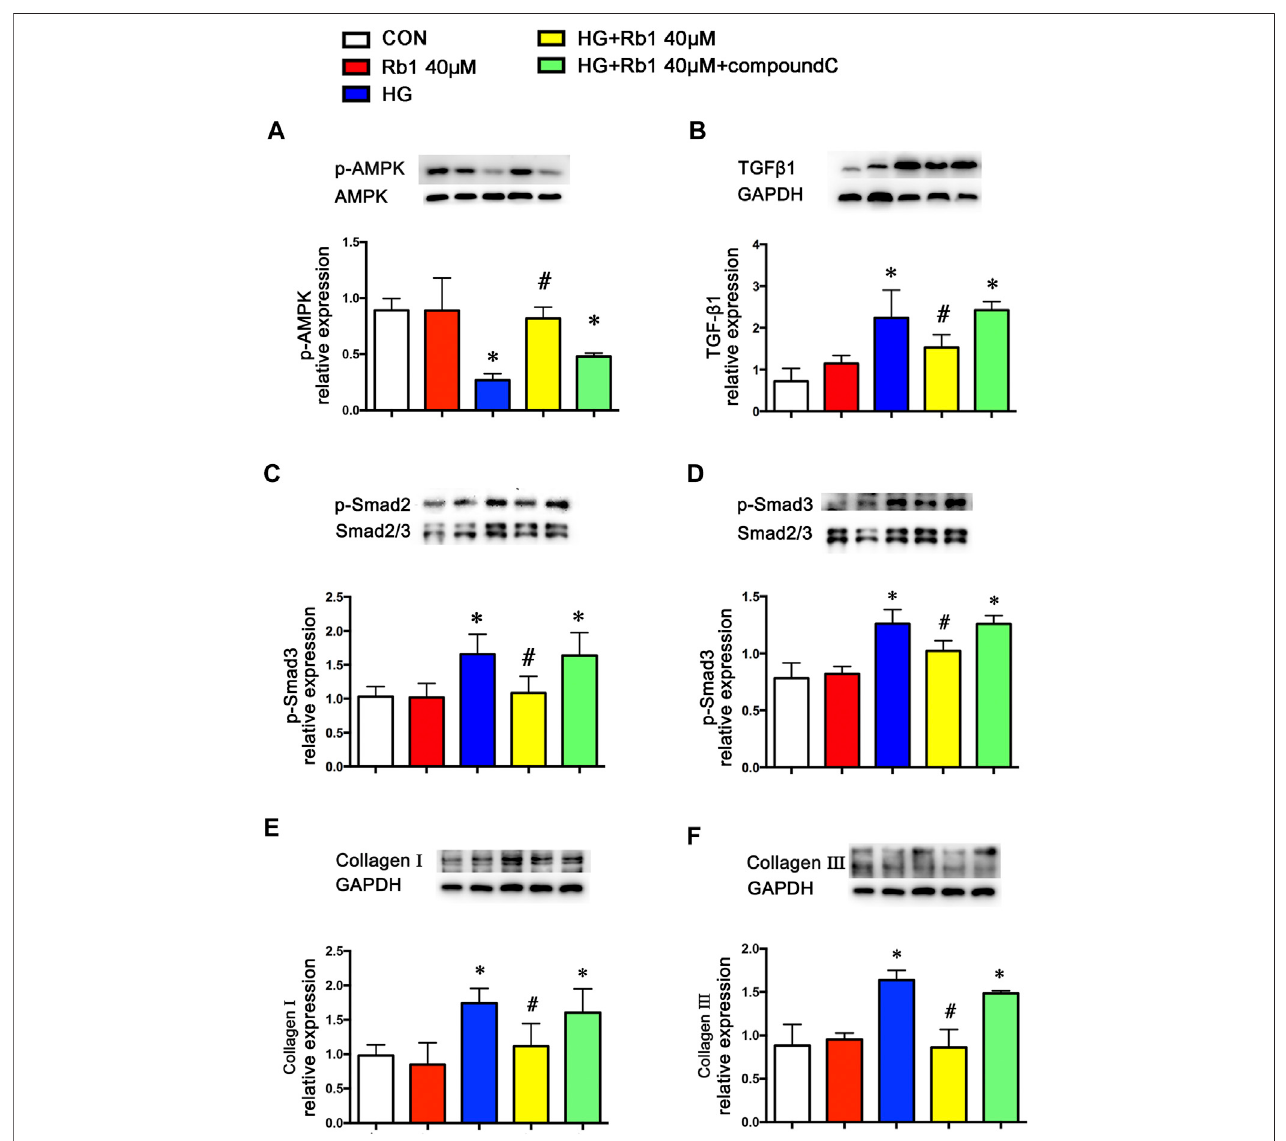
FIGURE4| Rb1-mediatedreductionofTGF β 1andphospho-Smad2/3andcollagenaccumulationarepartlyabolishedbytreatmentwithcompoundC,aninhibitor of AMPK. VSMCs were treated with Rb1 at doses of 40 μ M in a high-glucose medium and pretreated with compound C. Representative Western blot bands and semiquantitative analysis of (A) phosphorylated AMPK (p-AMPK), (B) TGF β 1, and (C) phosphorylated Smad2 (p-Smad2). (D) Phosphorylated Smad3 (p-Smad3). (E) Collagen I and (F) collagen III. Data are mean ± SEM. n (cid:2) 5 – 6, * p < 0.05 vs. Control; # p < 0.05 HG + Rb1 vs. HG.